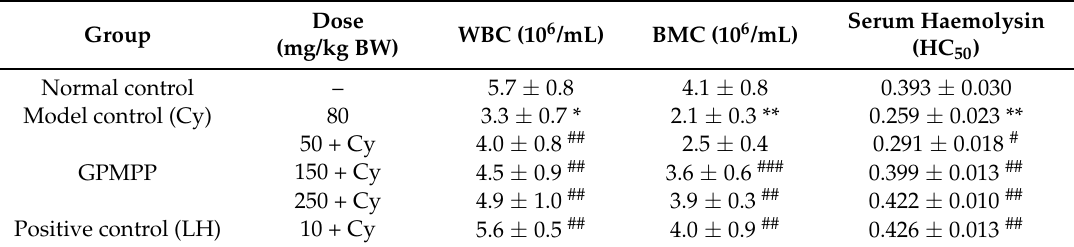
Table 2. Effects of GPMPP on numbers of white blood cells (WBC) and bone marrow cells (BMC), and haemolysin in sera in Cy-immunosuppressed mice. Group